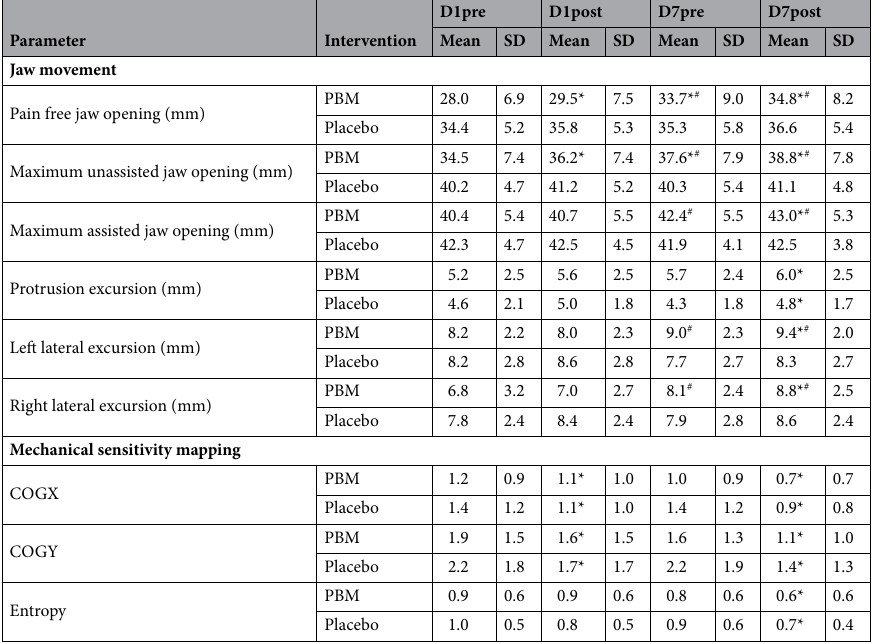
Table 2. The descriptive statistics (mean ± standard deviation) and results of analysis regarding the test parameters of the masseter myalgia group during the experiment (n = 50). Photobiomodulation (PBM) group (n = 25); Placebo group (n = 25); “*” indicates significant difference between D1-pre and other time points (P < 0.05); “#” indicates significant differences between PBM and placebo (P <